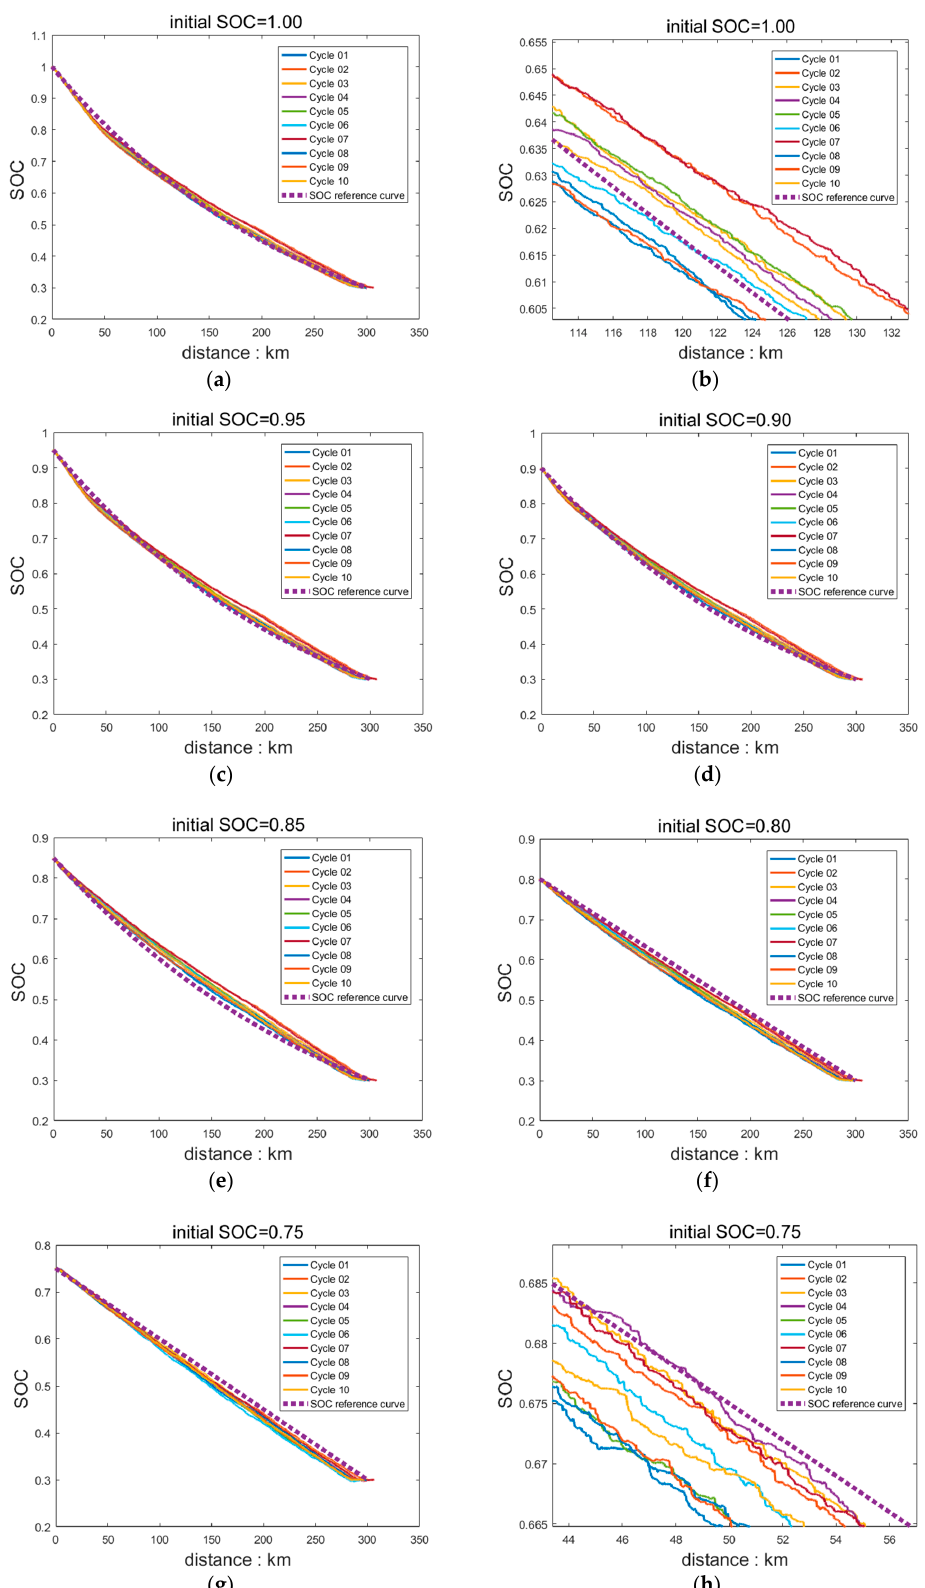
Figure 10. The SOC change curve of 10 cycles under optimal solution by PMP in different initial SOC: Among them, ( b ) and ( h ) are ( a ) and ( g ) partially enlarged image, respectively.